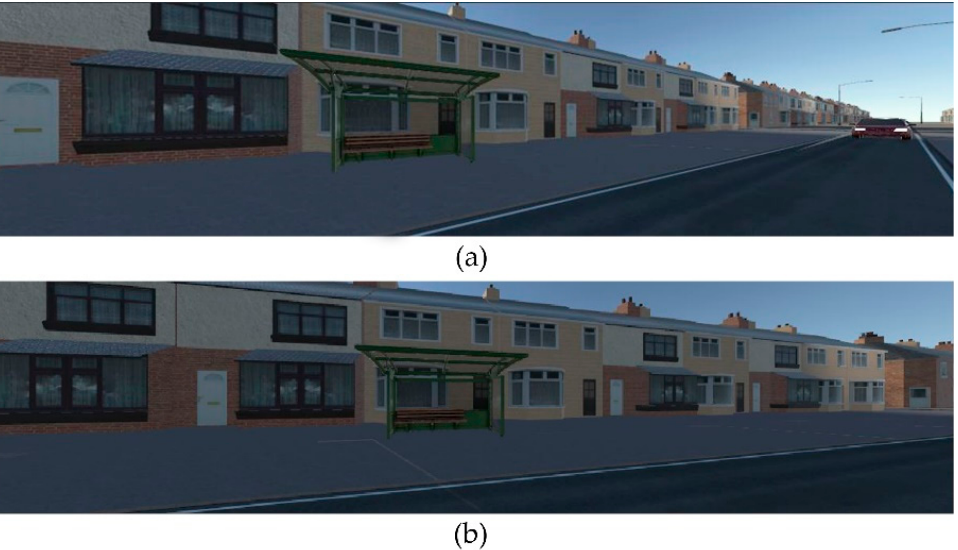
Figure 4. View in the virtual environment from the participant’s perspective. ( a ) Road and traffic are within the subject’s visual field. ( b ) Road and traffic are not within the visual field of view. By looking at the screen recording of the subjects’ view, it was possible to determine the amount of time that participants spent checking the traffic.